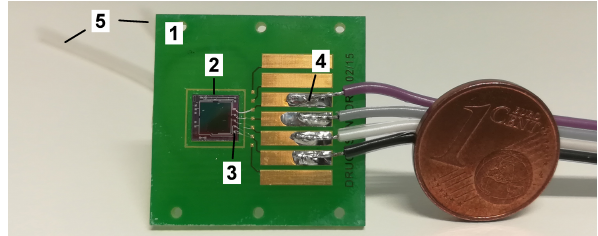
Figure 3. Hydrogel-based piezoresistive sensor for the detection of ethanol; (1) circuit board, (2) pressure sensor chip with hydrogel filled in the cavity, (3) bonding islands with bonded gold wires, (4) soldered connection cables, (5) inlet and outlet hoses to the pump.